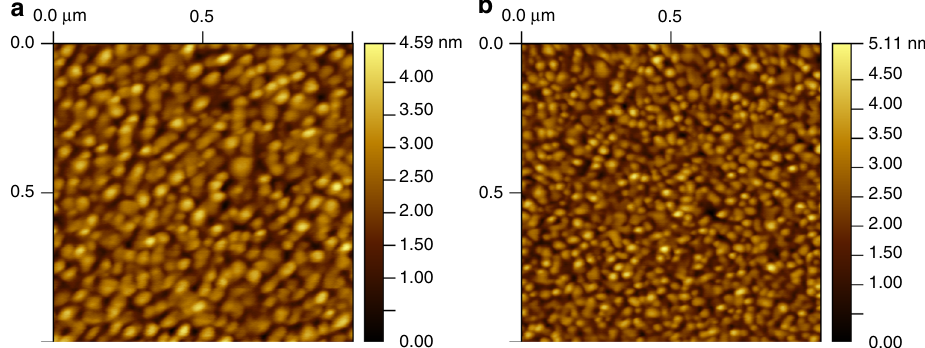
Fig. 4 AFM images on the Au surface. a Au deposited at 0.5 Ås − 1 . b Au deposited at 2.5 Ås −